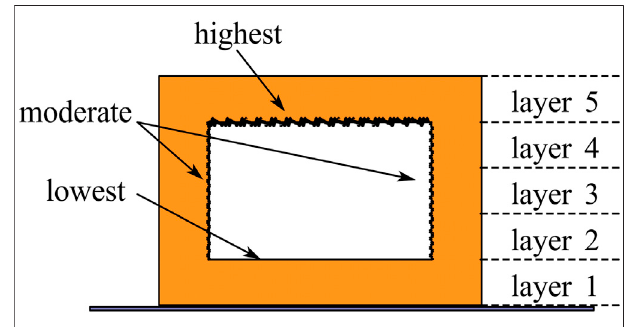
FIGURE 8 | Schematic diagram of surface roughness on side